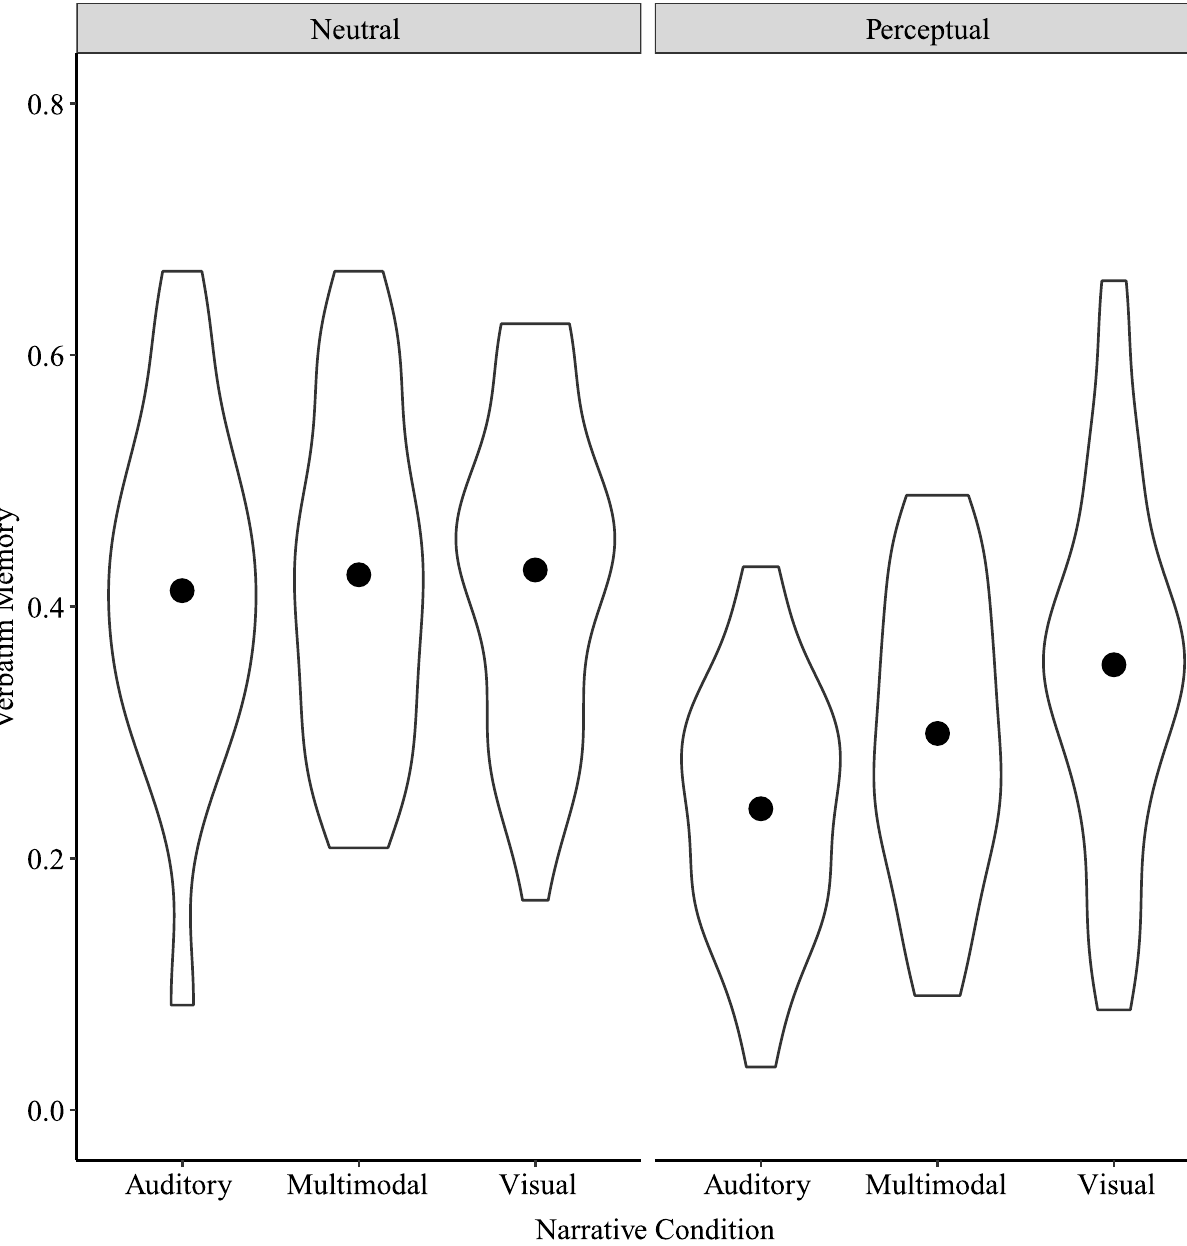
Fig 7. Verbatim memory by Narrative Condition and Detail Type for Study 2. Points show means for each Narrative Condition by Detail Type.